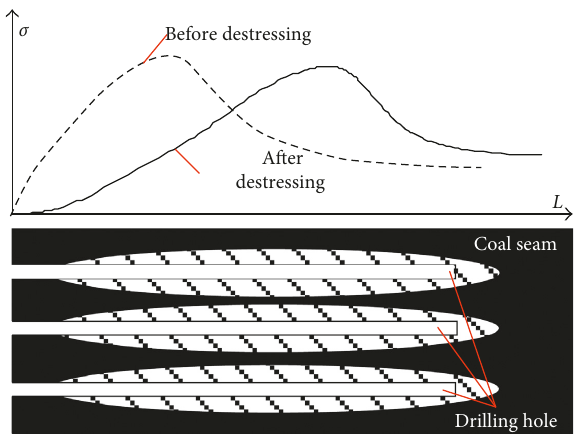
Figure 1: Sketch of destress drilling in coal